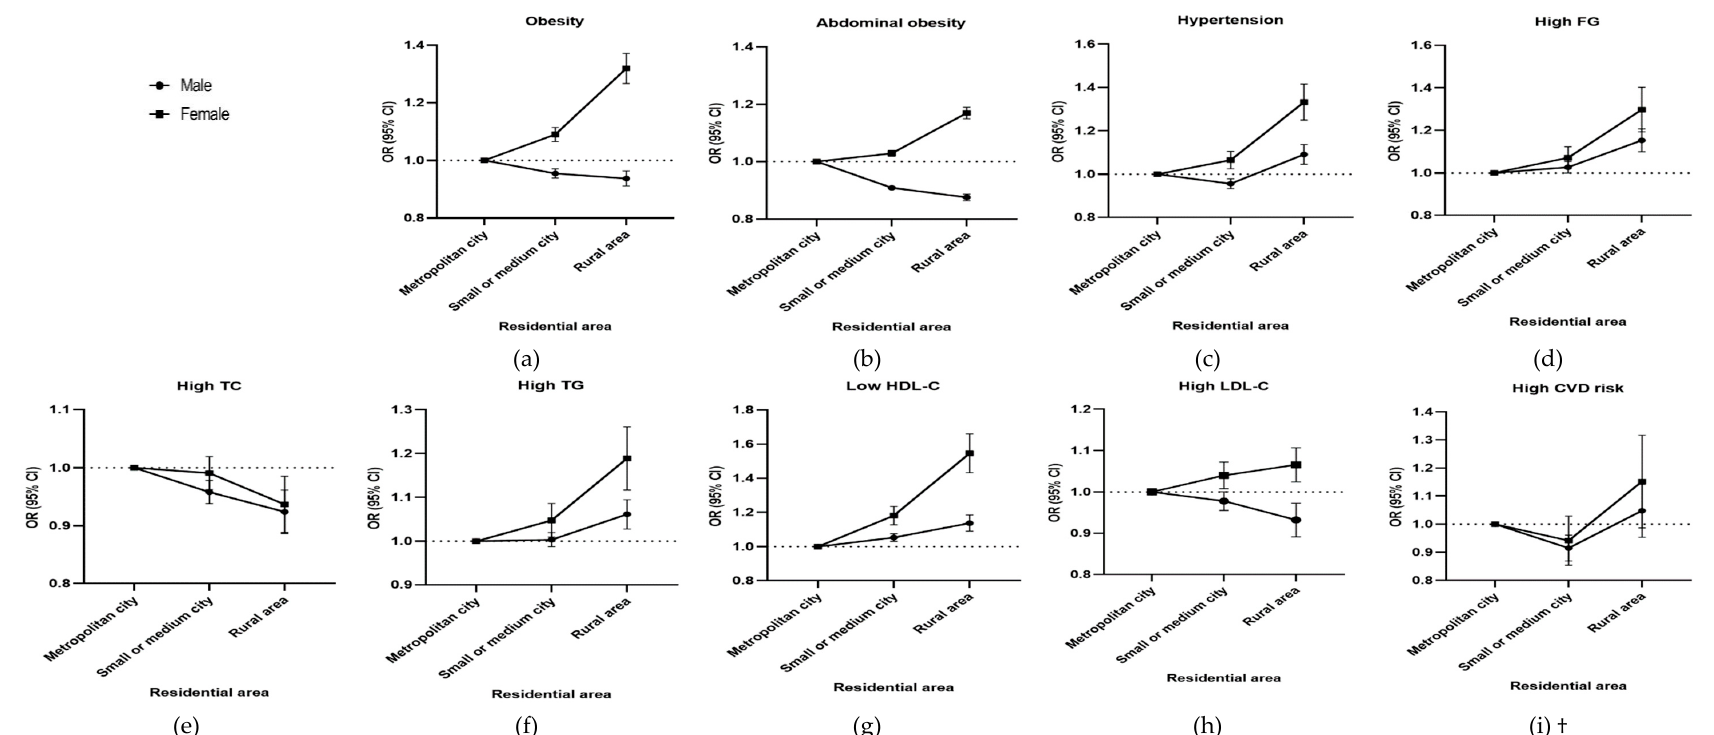
Figure 3. Odds Ratio (OR) of CVD-related health status by residential area. ( a ) OR of obesity by residential area, ( b ) OR of abdominal obesity by residential area, ( c ) OR of hypertension by residential area, ( d ) OR of high FG by residential area, ( e ) OR of high TC by residential area, (f) OR of high TG by residential area, ( g ) OR of low HDL-C by residential area, ( h ) OR of high LDL-C by residential area, and ( i ) OR of high CVD risk by residential area. † CVD risk only includes persons older than 30 years and excludes the 58,308 subjects with either a related medical history or currently taking medicines related to CVDs, such as stroke and heart disease. Adjusted for age, income level, smoking, alcohol consumption, and frequency of walking, moderate exercise, and vigorous exercise. Abbreviations: OR, odds ratio; CI, confidence interval; FG, fasting glucose; TC, total cholesterol; TG, triglyceride; HDL-C, high density lipoprotein-cholesterol; LDL-C, low density lipoprotein-cholesterol; CVD, cardiovascular disease. Error bars indicate 95% CI.